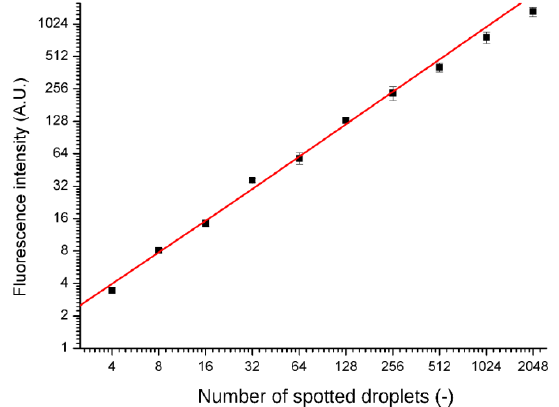
Figure 3. A relationship between the spotted amount of dye and normalized fluorescence (each point is an average from 4 wells). The fluorescent measurement was performed after 6 h of filling the chip, i.e., after a typical culture time. Red line is a linear fit of the data points (R 2 = 0.96779)